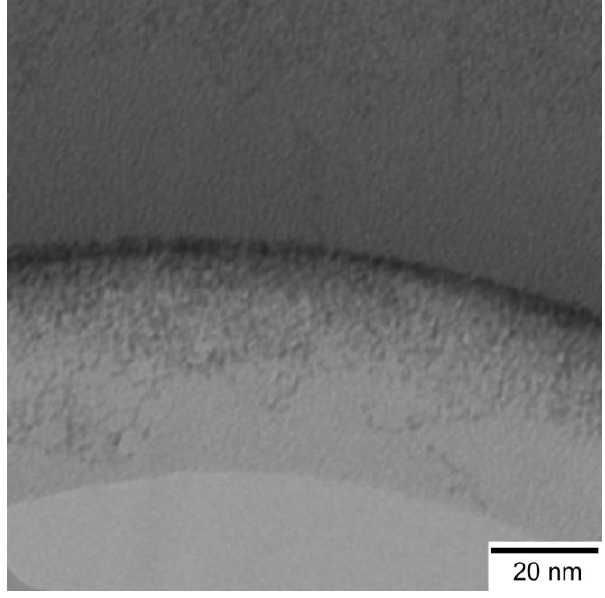
Figure 1. Transmission electron microscopy images of ceria sols.